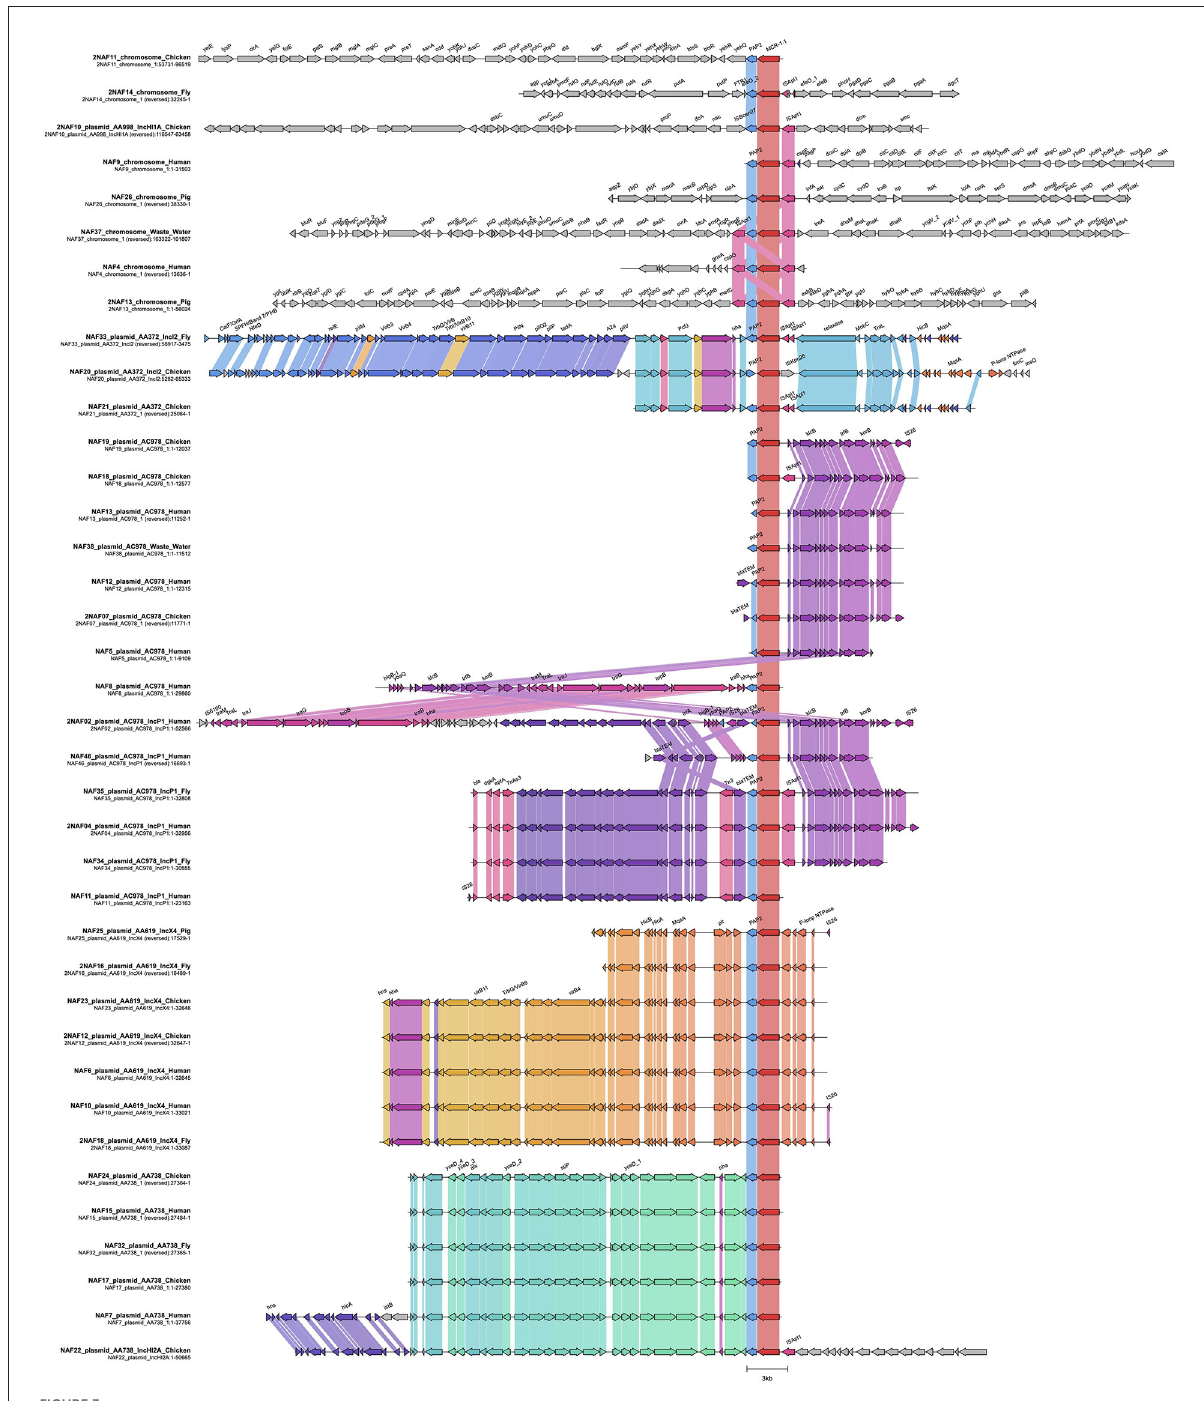
FIGURE3 Representative of sequence alignment of mcr-1 -containing cassettes. Arrow indicates an open reading frame and the direction of transcription. ISApl1 is indicated by the pink arrow, mcr-1 is indicated by the red arrow, the hypothetical gene is indicated by the gray arrow, and intrinsic genes of the plasmid backbone or chromosome are indicated by orange arrows. Color shadings connect regions of > 99% similarity.